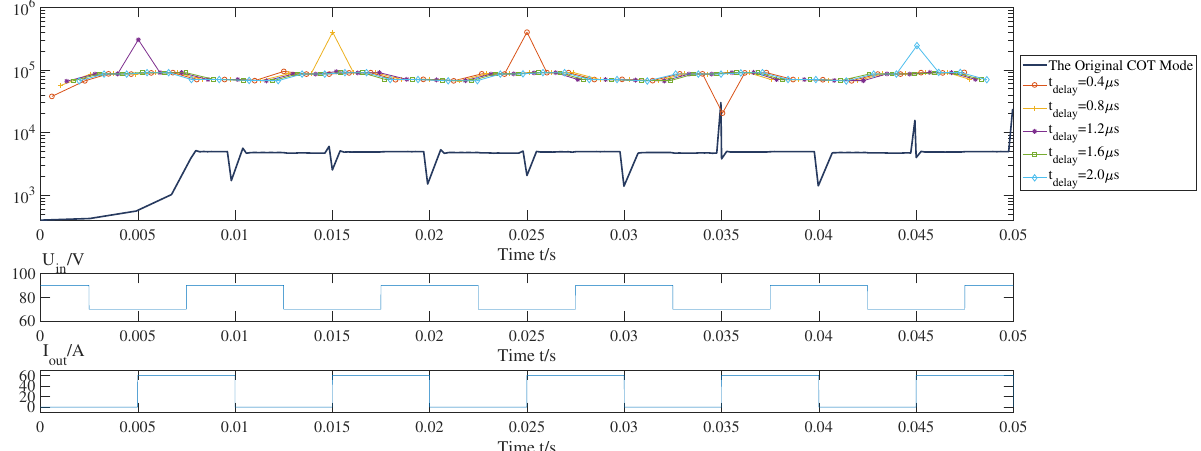
Figure 7. The operating frequencies of the Buck circuit in PD-COT